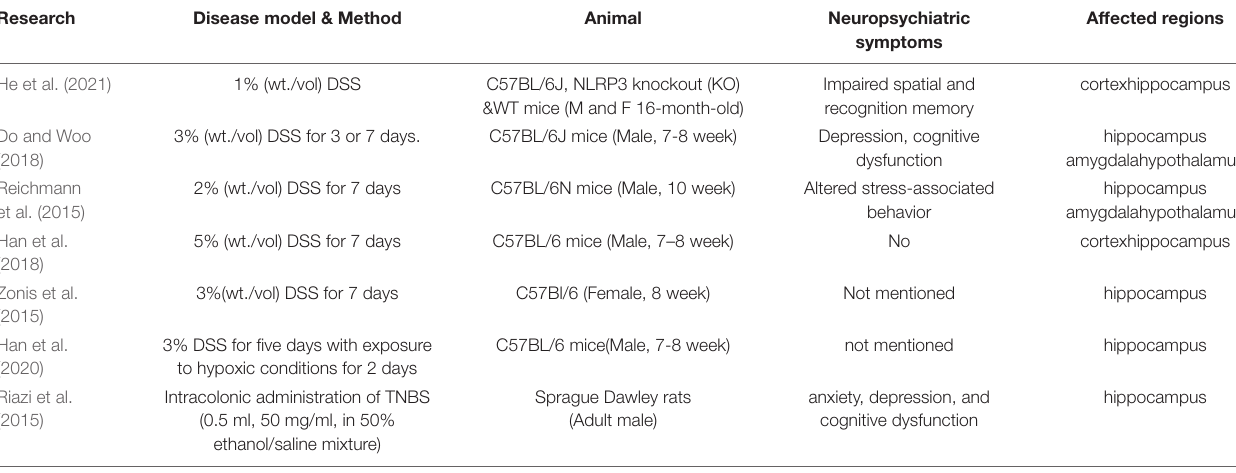
TABLE 1 | Animal experiments on the relationship between colitis and inflammation in the brain.